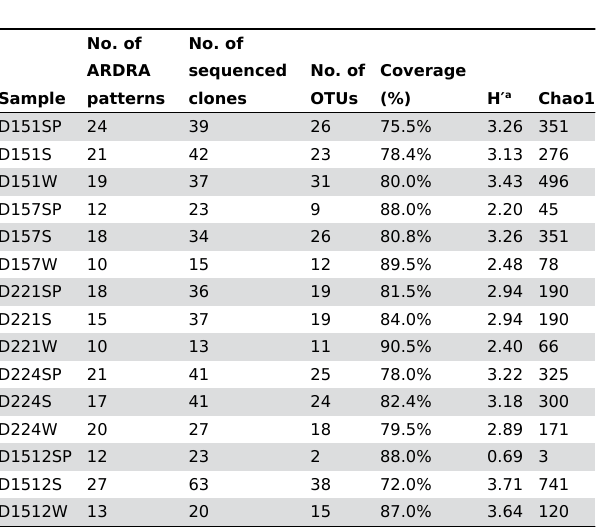
Table 2. Analyses of the 15 bacterial clone libraries in the South China Sea.